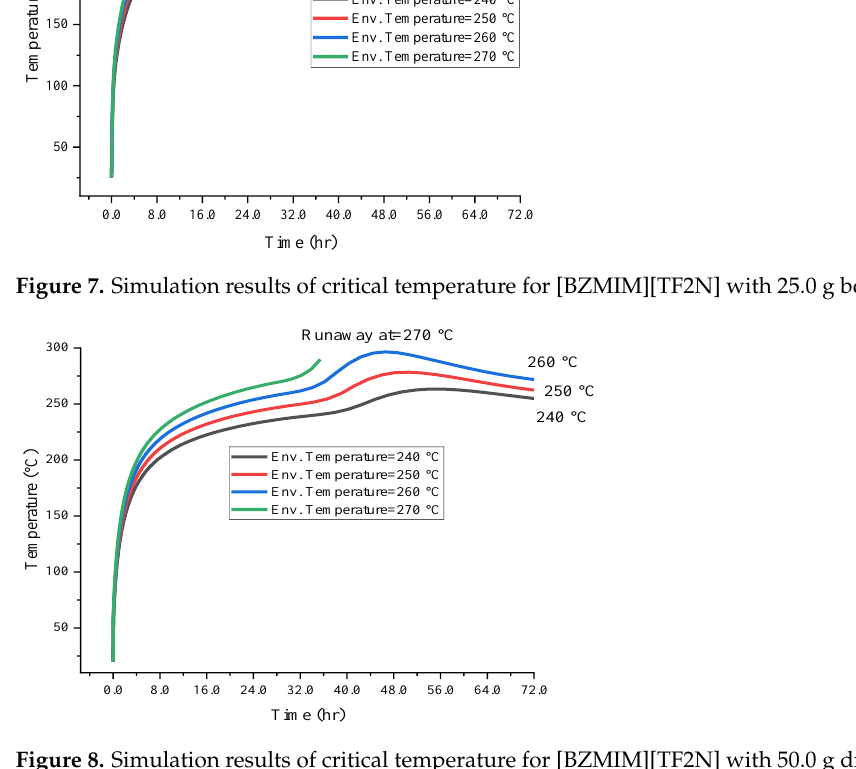
Figure 8. Simulation results of critical temperature for [BZMIM][TF2N] with 50.0 g drum packages.